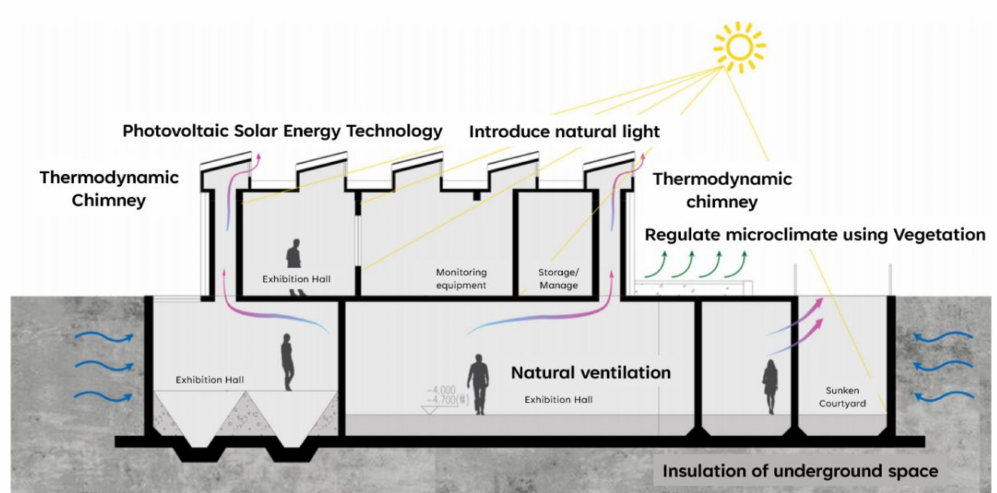
Figure 4. Building diagram of Zero-Carbon Pavilion in Shanghai Yangpu